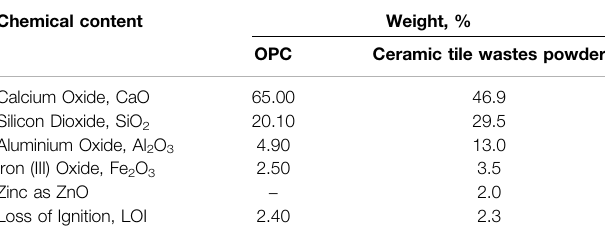
TABLE 1 | Chemical composition analysis by weight percentage of the localized OPC and ceramic tile wastes used (Lim et al., 2013; Global Bio Synergy Sdn. Bhd